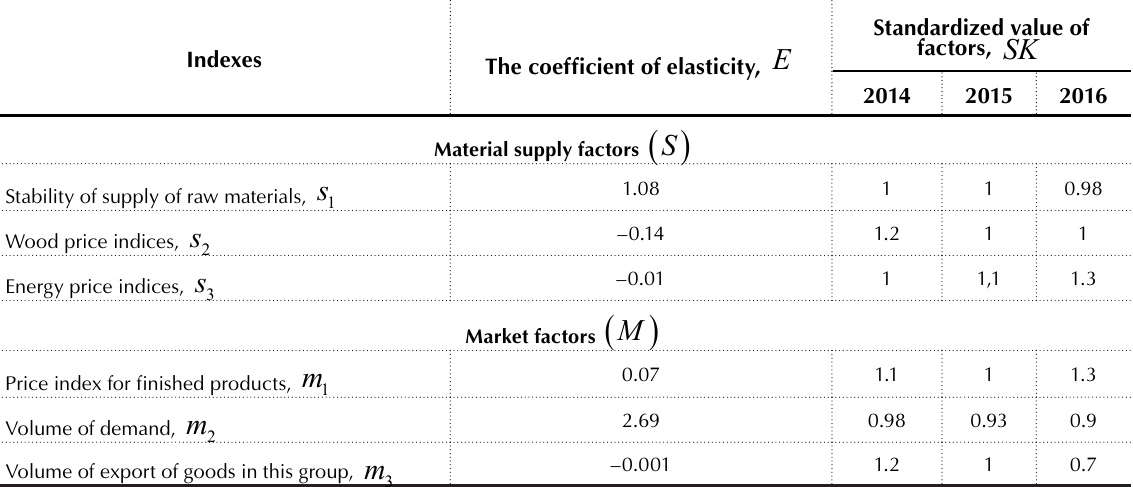
Source: calculated by the authors. Standardized value of factors,